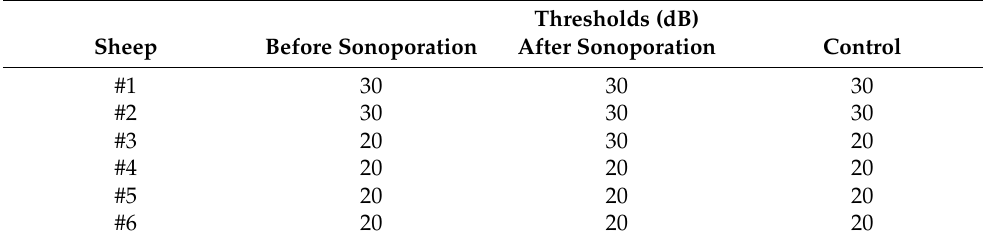
Table 2. Latency measurements for Wave IV in milliseconds (ms) at 30 and 20 dB for each sheep before and after sonoporation, and for control side. # indicates missing